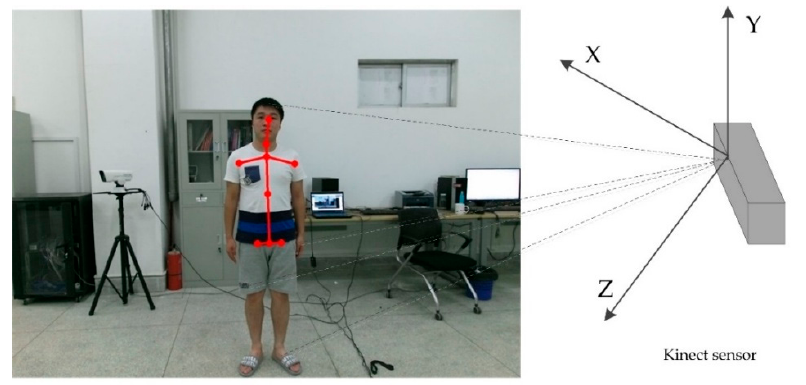
Figure 4. Skeleton extraction using Microsoft Kinect sensor in our experiments.